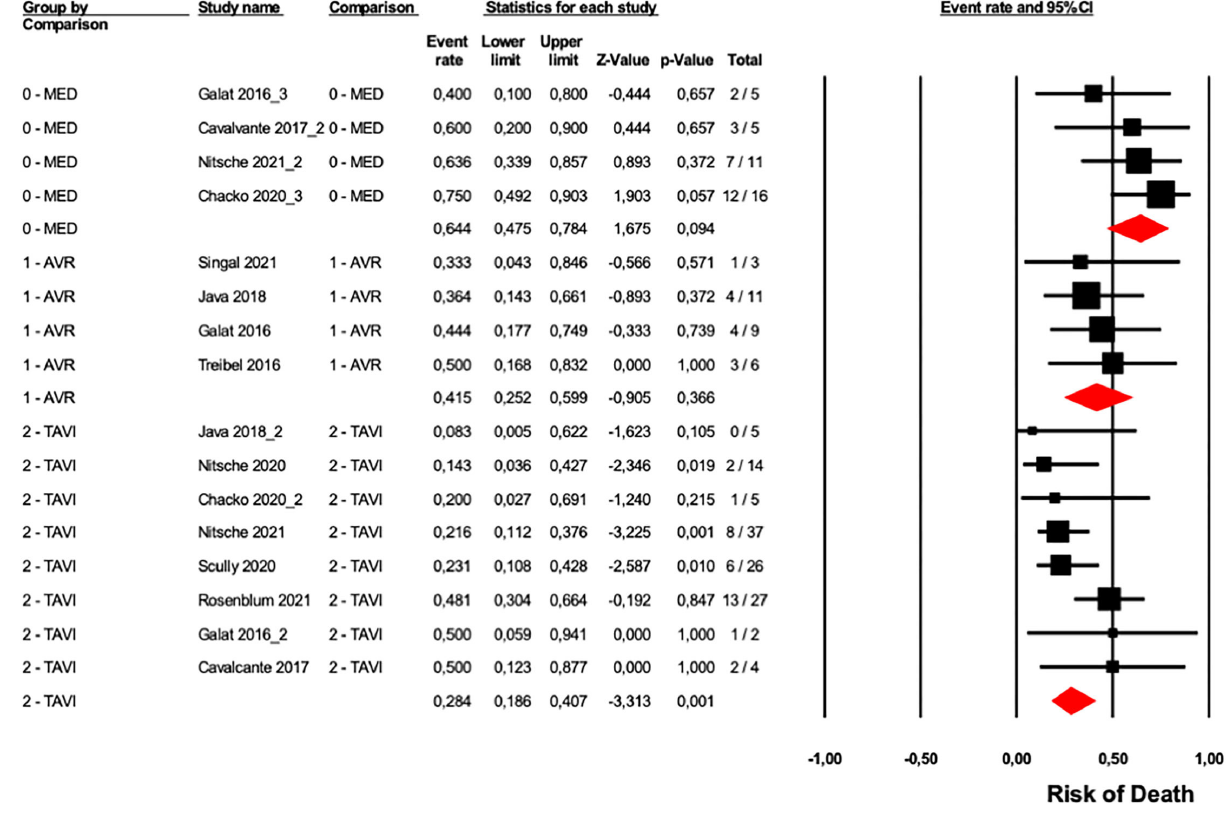
FIGURE 5 | Forest plots of overall mortality in a different type of treatment in AS patients with CA. Overall mortality was evaluated with the difference in event rate between different types of AS patients treatments with and without CA. The diamond represents the estimated overall effect, while the squares represent each study with